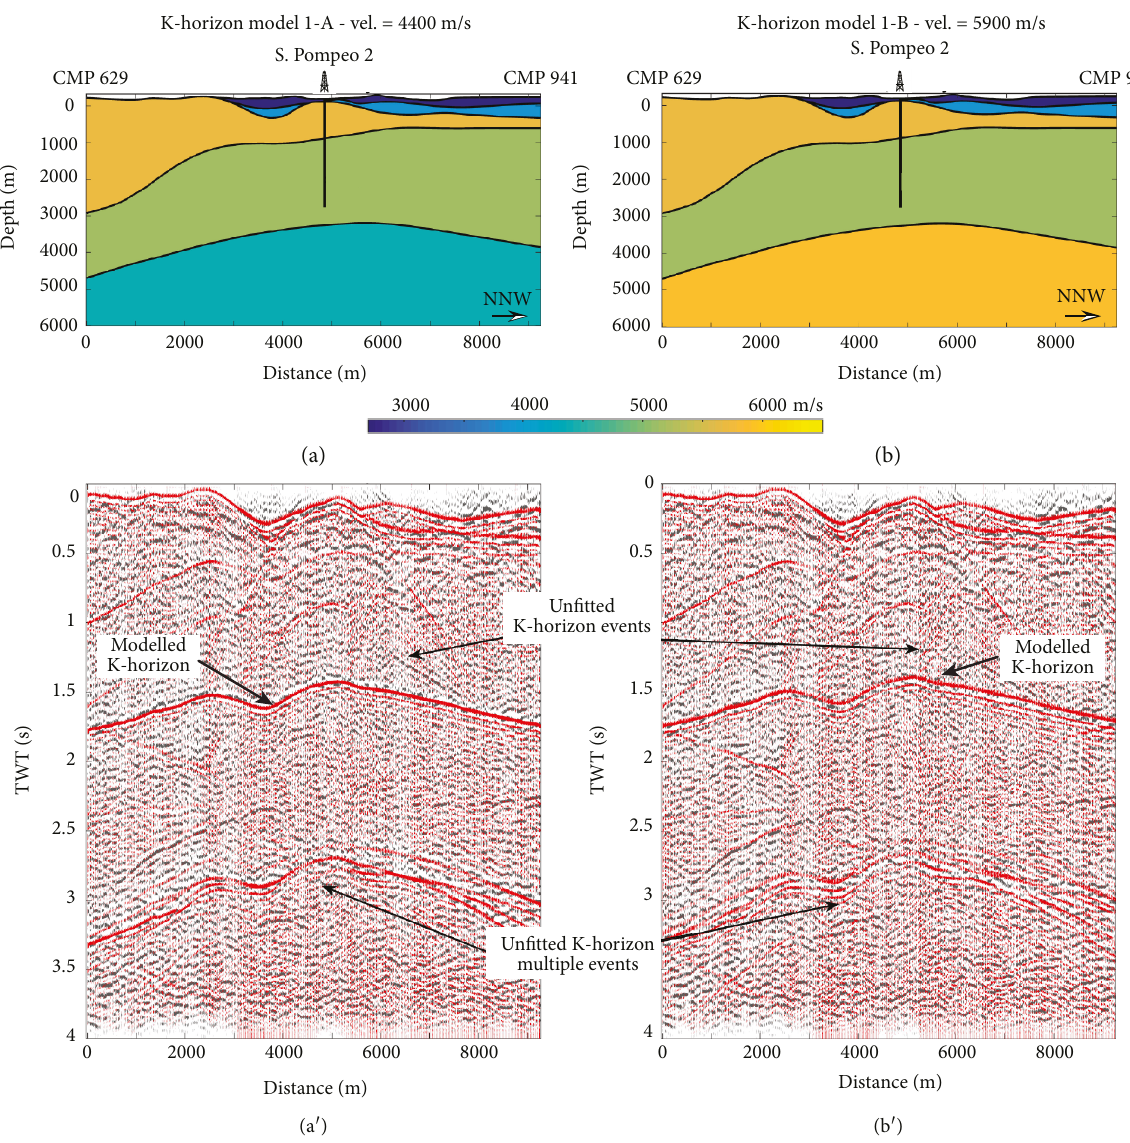
Figure 9: (a) Velocity model, named model 1-A, based on the 3D-geological reconstruction and imposing a velocity value of 4400 m/s for the geological unit below the K-horizon. (b) Velocity model, named model 1-B, based on the 3D-geological reconstruction and imposing a velocity value of 5900m/s for the geological unit below the K-horizon. (a ′ ) Modelled stacked sections for model 1-A (a) with P velocity of the unit below the K-horizon of 4400 m/s. (b ′ ) Modelled stacked sections for model 1-B (b) with P velocity of the unit below the K-horizon of 5900m/s. The modelled seismic response, plotted in positive variable area in red, is superimposed onto the processed stacked data, plotted in